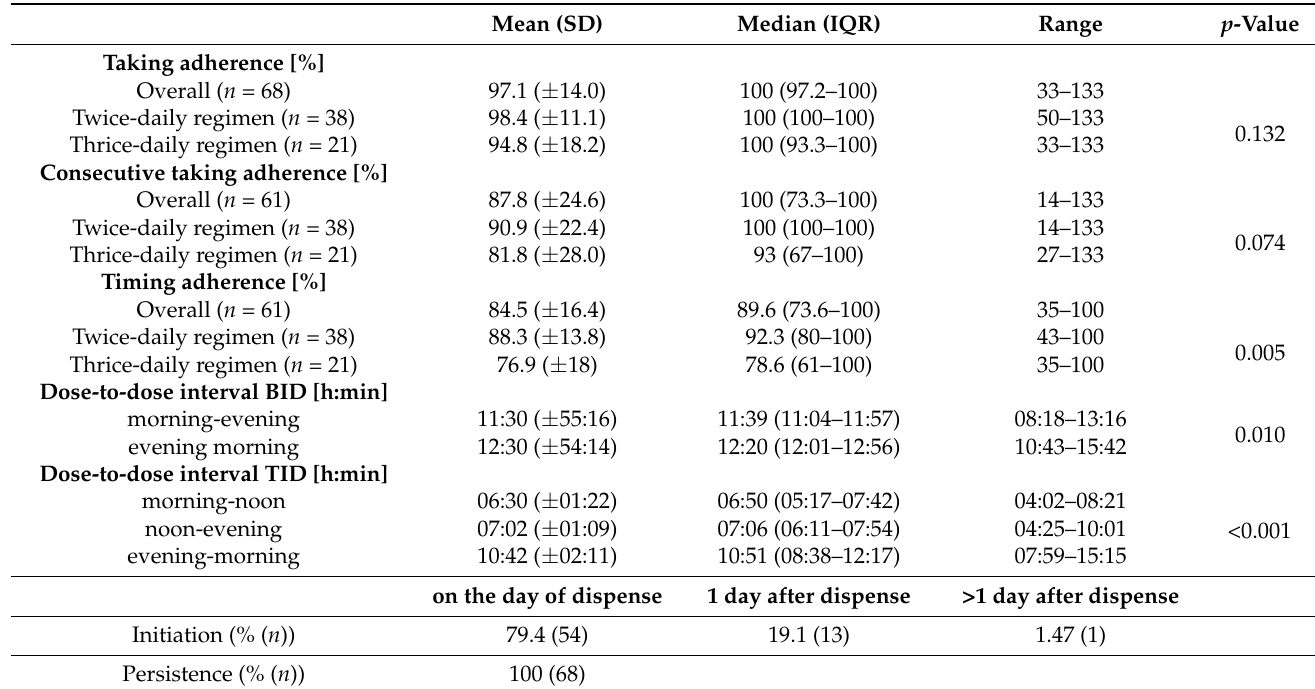
Table 2. Medication adherence estimates from the patients participating in the construct validation study ( n = 68). Patients with a once-daily regimen ( n = 2) were excluded from the sub-analysis. For estimates calculated, see statistical analysis in section 2.